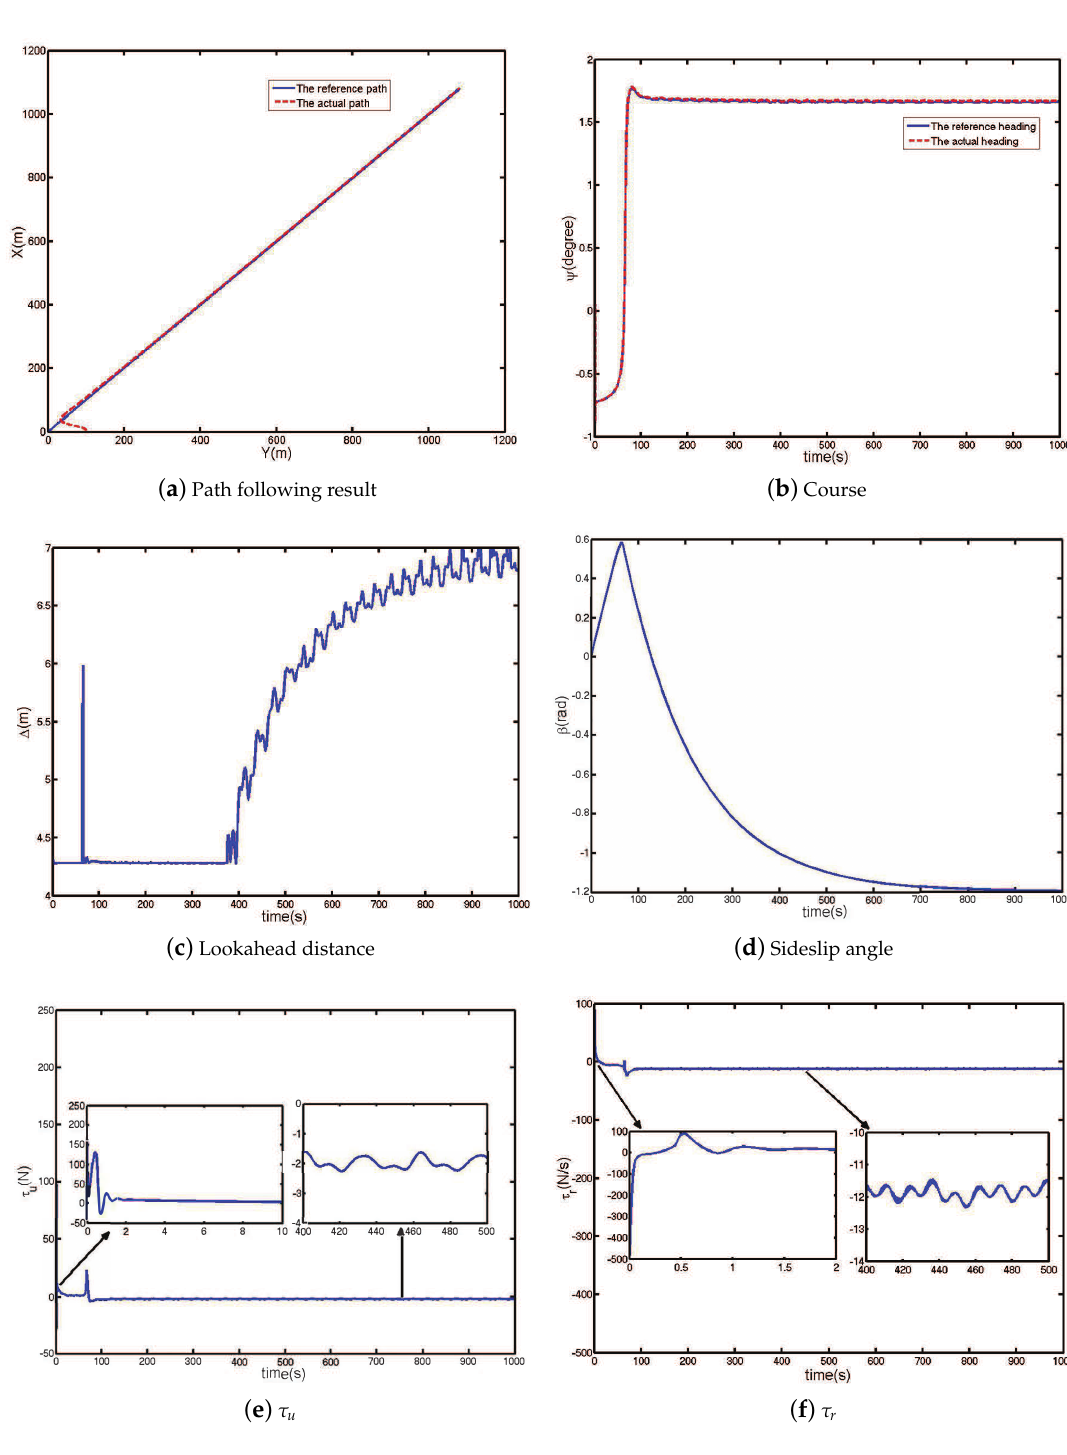
Figure 4. The results of the straight-line path